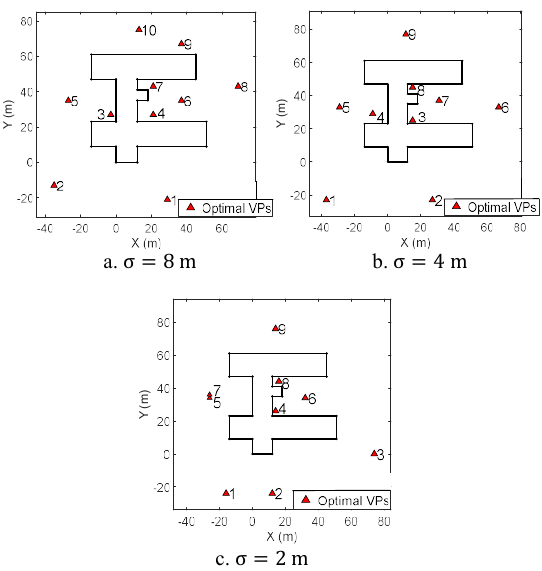
Figure 7. Solutions from the “Non-hierarchical + GA” strategy for Crowsnest: three resolutions corresponding to three levels of resolutions in Figure 6 are applied.